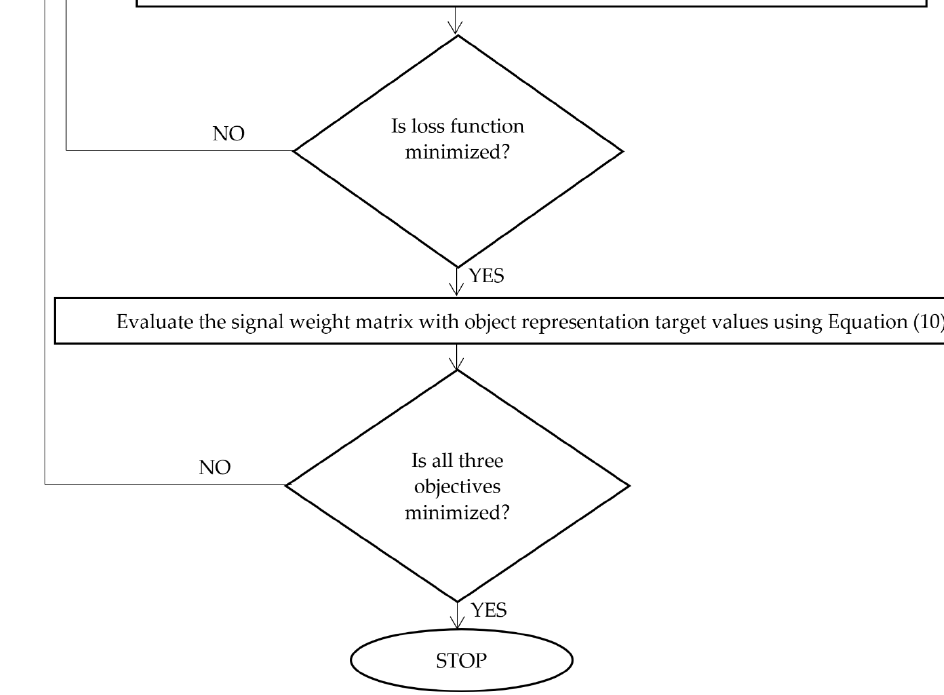
Figure 2. Flowchart of DL for wearable healthcare applications.